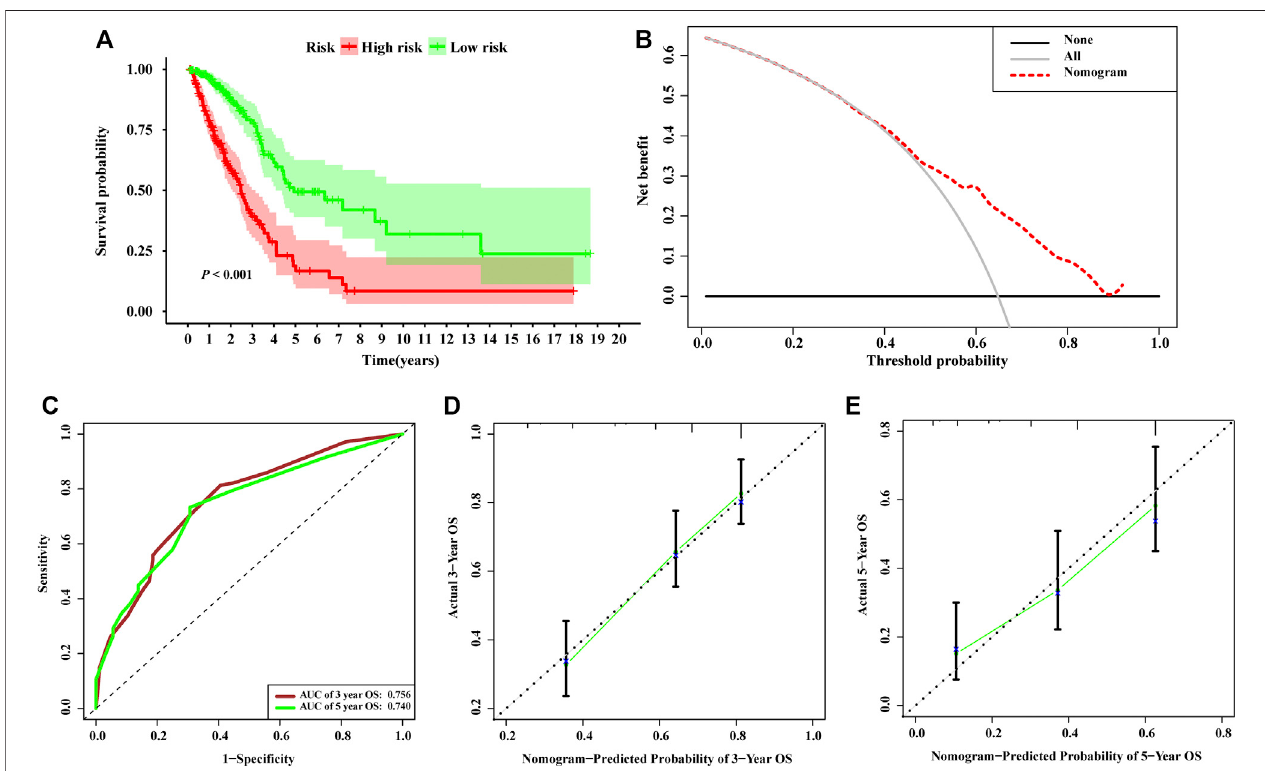
FIGURE 6 | Assessment of the nomogram incorporating the risk scores generated from the signature. (A) Kaplan – Meier survival analysis curves of the high-risk groupandlow-riskgroupdividedbythenomograminTCGA-LUADset. (B) DecisioncurveanalysisevaluatingtheclinicalusefulnessofthenomogramforLUADpatients (C) Time-dependent ROC curves at 3- and 5-year follow-up. The calibration curves show the prediction of the nomogram for 3-year (D) and 5-year (E) .